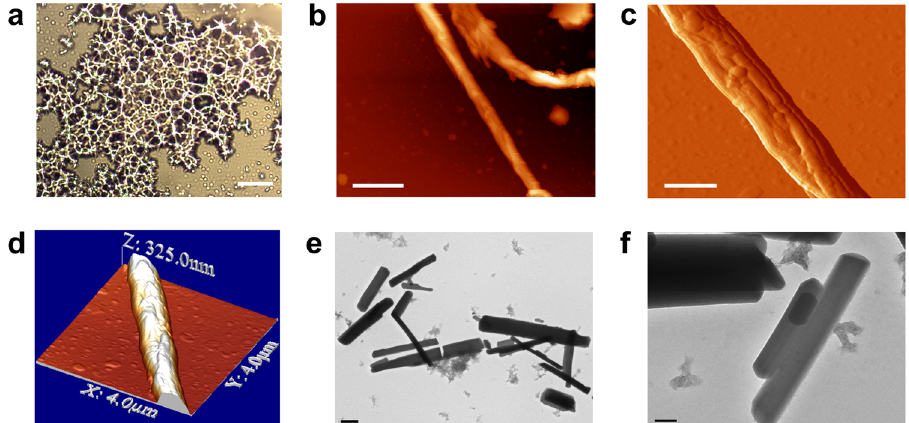
Fig. 2 Morphological characterization of the prepared fi brils. a Optical microscopy image showing instant fi brillation of egg white proteome with [Cho] [Tos] (scale bar = 10 μ m). b , c 2-D AFM (scale bars = 2.8 μ m and 800 nm) and d 3-D AFM images of freshly prepared fi brils showing entangles in the protein fi brils and fi bril oligomers in the background. d , e TEM images of the lyophilized protein fi brils showing one-dimensional nanorods (scale bars = 500 and 100